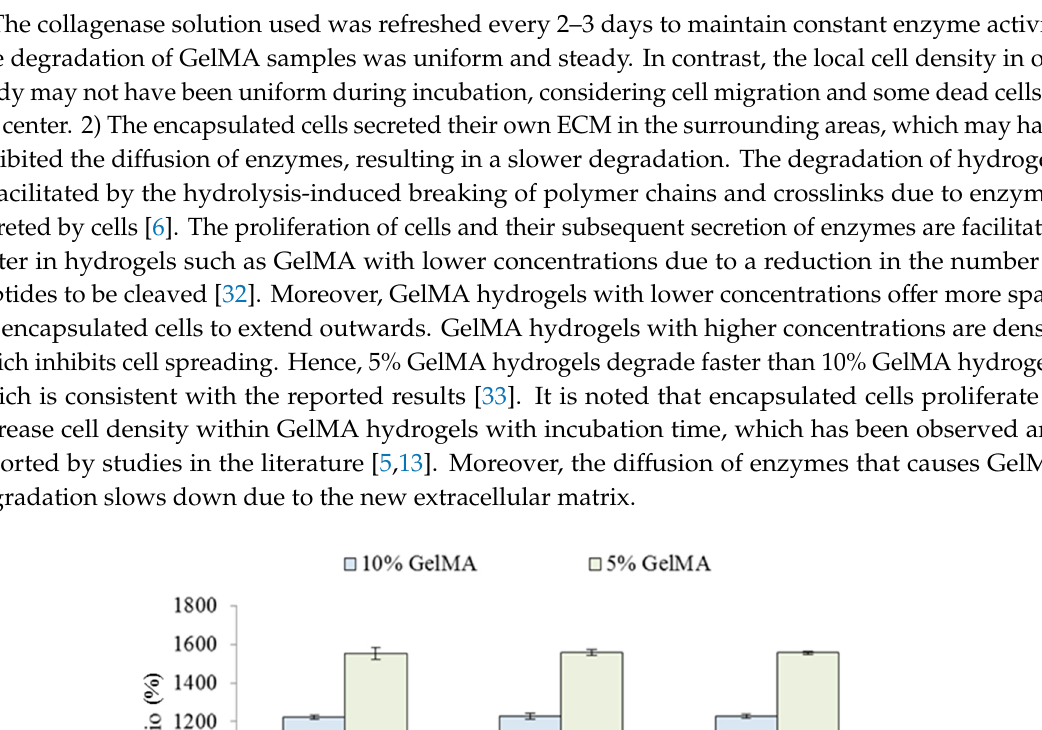
Figure 5. Tensile moduli of GelMA hydrogels with different GelMA concentrations and cell densities at different incubation times. The error bars indicate the minimum and maximum values of the calculated tensile moduli